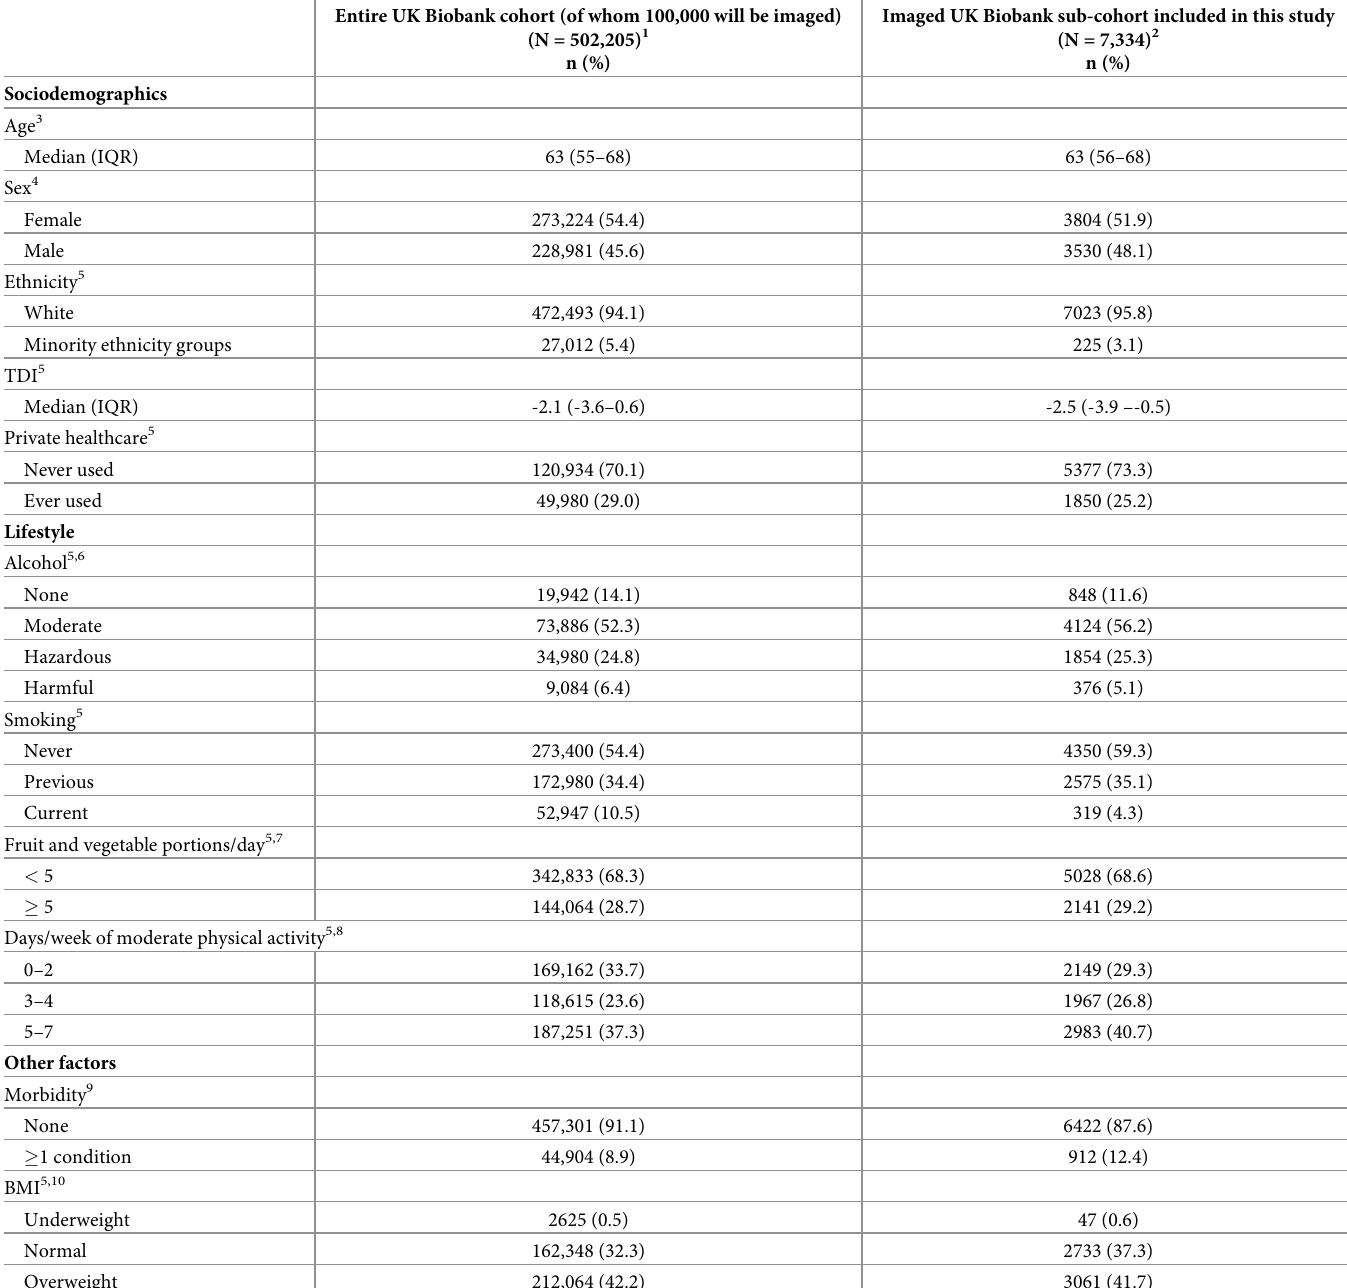
Table 1. Characteristics of the UK Biobank cohort and the imaged sub-cohort included in this